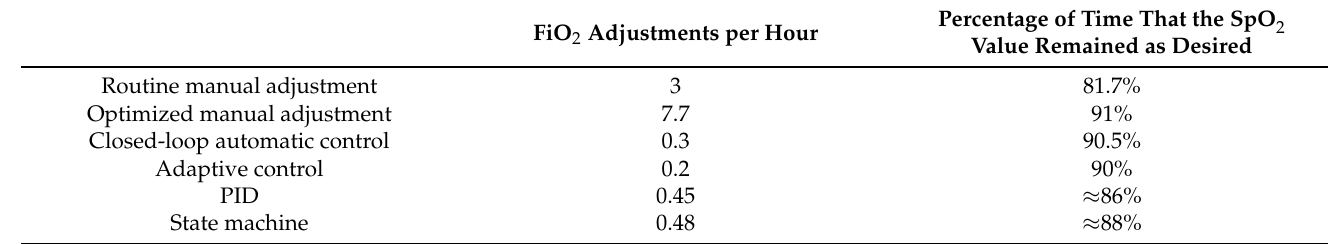
Table 5. Comparative between the adjustment of presented